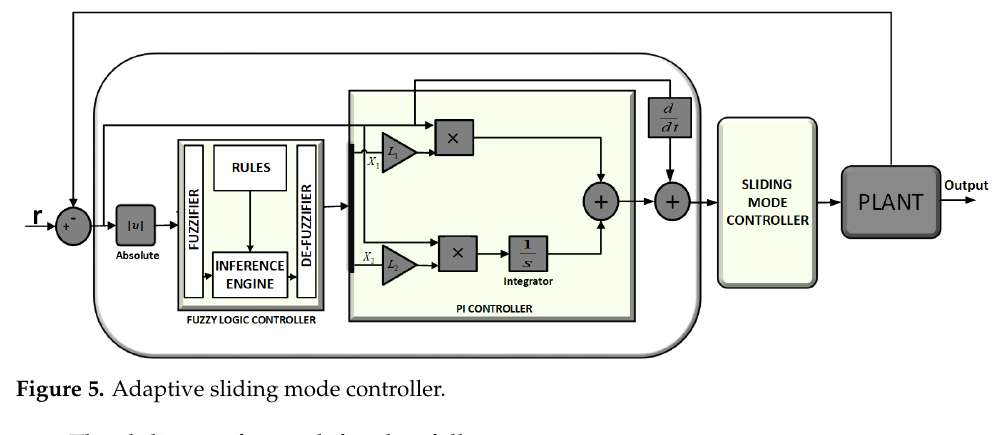
Figure 5. Adaptive sliding mode